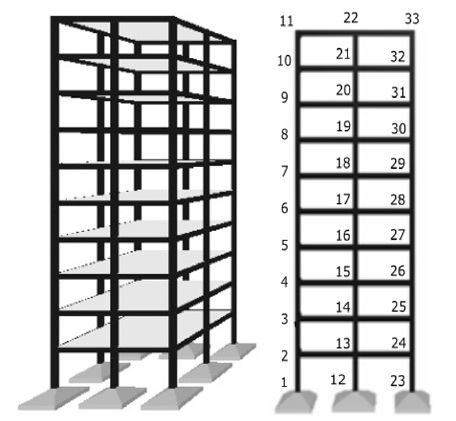
Figure 3. Case study